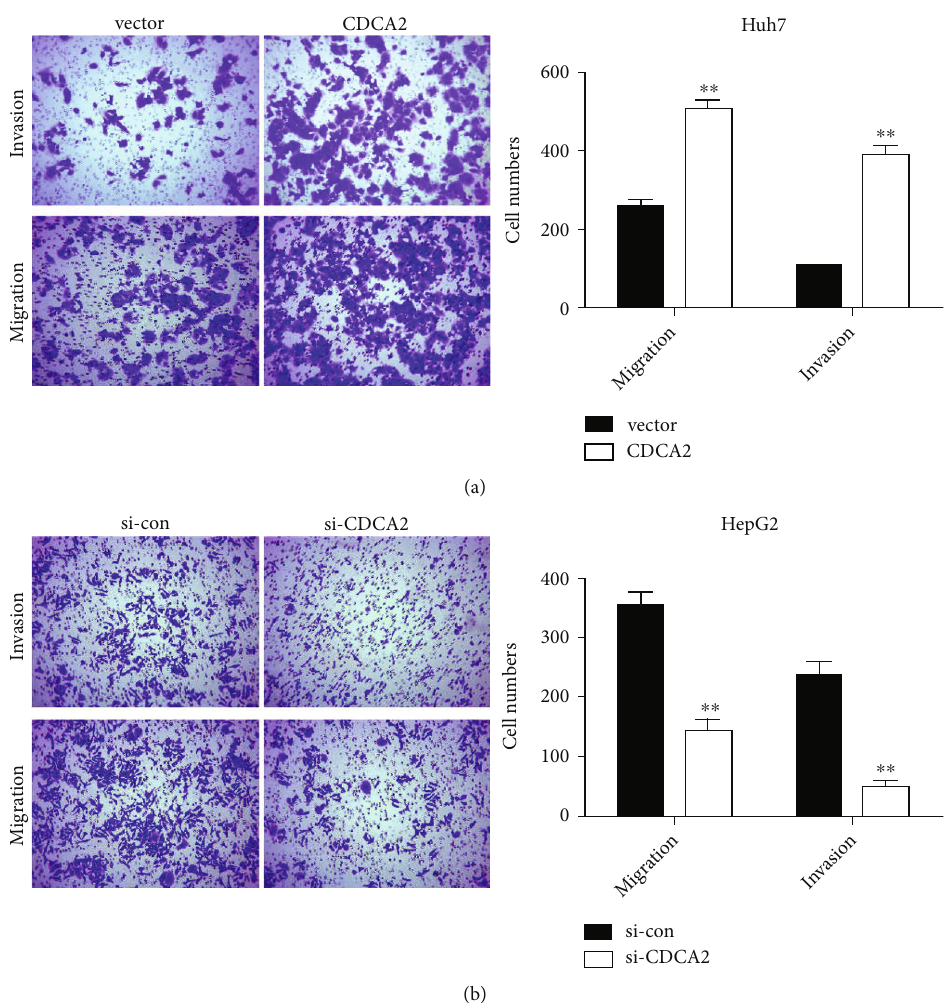
Figure 3: Aberrant expression of cell division cycle associated 2 (CDCA2) a ff ected the movement of hepatocellular carcinoma cells. (a) The invasion and migration abilities of Huh7 cells were obviously enhanced with CDCA2 overexpression. (b) Silencing of CDCA2 repressed the movement ability of HepG2. ** p < 0 : 01 versus vector or